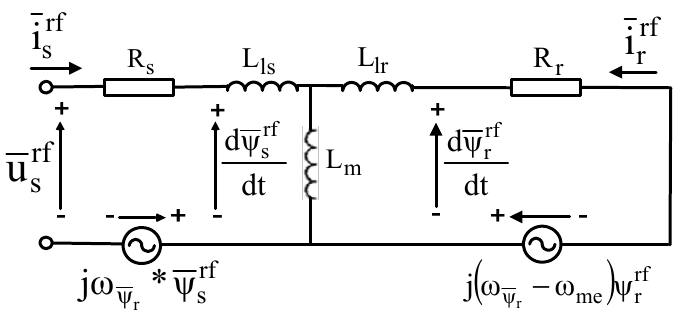
Figure 1. Modeling of IM in the synchronous rotating frame.